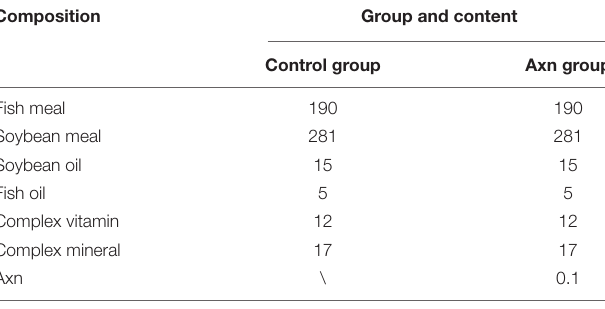
TABLE 1 | The composition of the base feed (g kg − 1